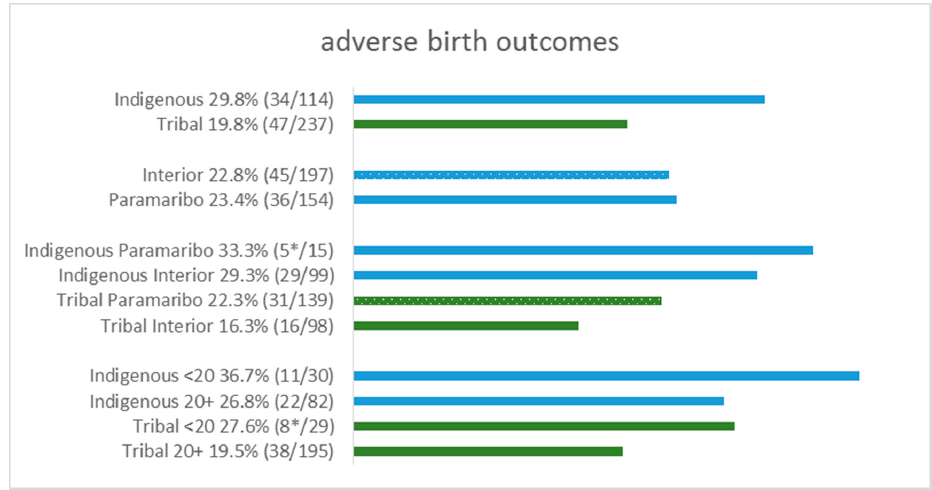
Figure 2. Rates of adverse birth outcomes stratified for ethnic background, geographical background, and age at delivery. * Rates are based on fewer than 10 ABO. Two-sample test for differences in proportions: Indigenous vs. Tribal ( p = 0.043); Interior vs. Paramaribo ( p = 1.000); Indigenous Interior vs. Indigenous Paramaribo ( p = 0.767); Tribal Interior vs. Tribal Paramaribo ( p = 0.321); Indigenous 16–19 years vs. Indigenous 20+ years ( p = 0.353); Tribal 16–19 years vs. Tribal 20+ years ( p = 0.328).